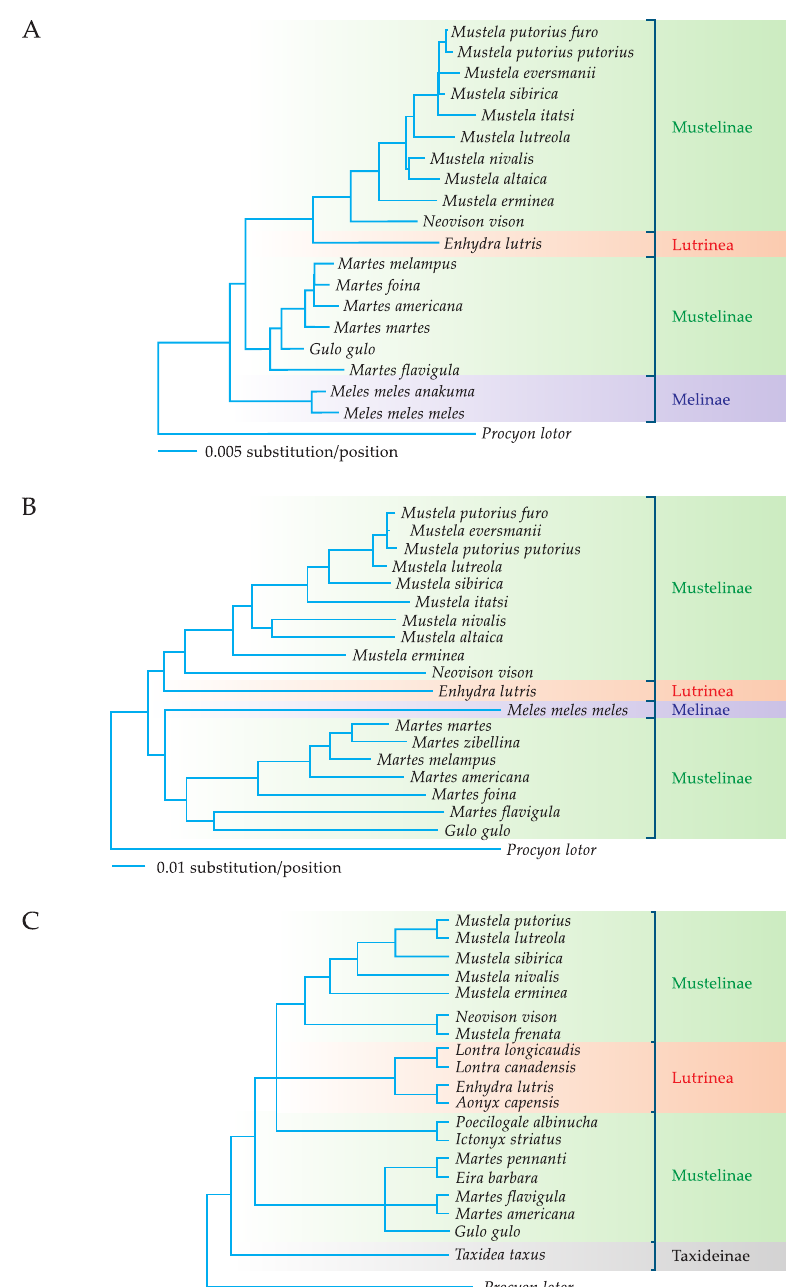
Figure 1. Dendrograms constructed for the Mustelidae family based on ( A ) nucleotide sequences (partial) of the irbp gene using the neighbor-joining method (the horizontal length of each branch is proportional to the number of nucleotide substitutions per site) [24], ( B ) complete nucleotide sequences of the cytb gene using the neighbor-joining method (the horizontal length of each branch is proportional to the number of nucleotide substitutions per site) [24], and ( C ) the sequences of 12S rRNA, cytb , ND2 , tbg , irbp, and ttr (first intron) genes using the maximum parsimony method with bootstrap support (1000 replicates)